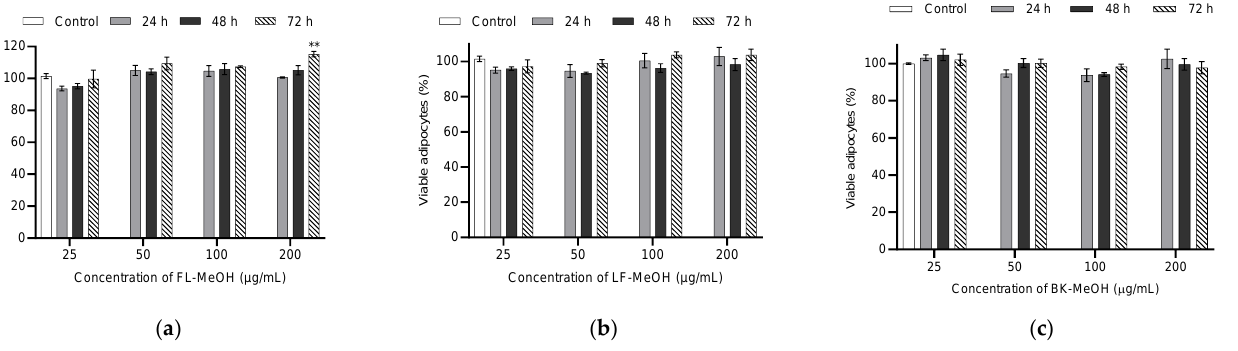
Figure 2. Bar charts of the percentage of viability of 3T3-L1 adipocytes treated with ( a ) FL-MeOH, ( b ) LF-MeOH, and ( c ) BK-MeOH extracts (ANOVA, Dunnett, n = 3, ** p = 0.003 of treatment with FL-MeOH for 72 h against the vehicle control (0.1% DMSO)).